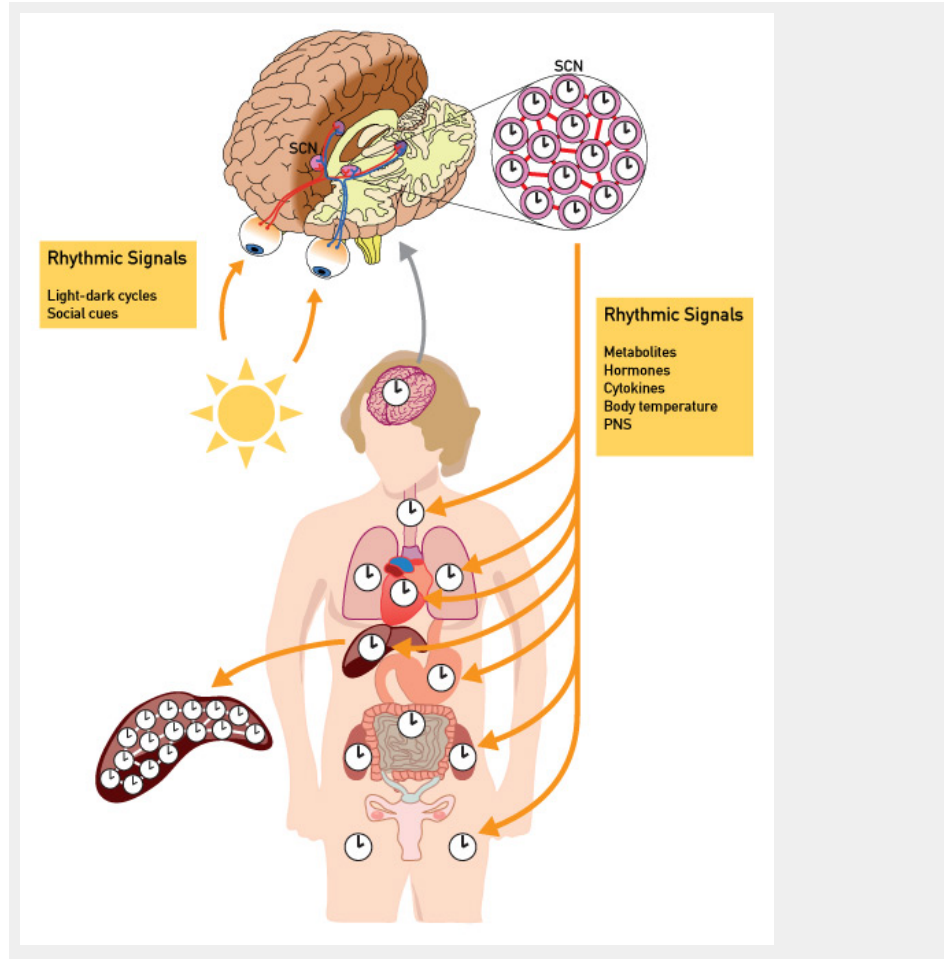
Figure 2 Molecular architecture of the mammalian circadian timing system. Virtually all of our 3.5x10 13 cells contain a circadian oscillator with the molecular makeup depicted in figure 1. The suprachiasmatic nucleus (SCN) harbours the central clock, which is responsible for all overt rhythms in behaviour and physiology. It is composed of two tiny agglomerates of neurones, whose oscillators are coupled through synaptic and paracrine signalling mechanisms (represented as red lines connecting the clock neurones). The phase of the SCN is adjusted to geophysical time every day by light signals perceived in the retina. The clocks in peripheral cell types are synchronised by the SCN through a variety of systemic signals, including metabolites (e.g. nicotinamide adenine dinucleotides), hormones (e.g. cortisol), cytokines (e.g. transforming growth factor-β), body temperature, and neuronal signals from the peripheral nervous system. In the liver, the phases of oscillators remain coupled even in the absence of systemic signals from the